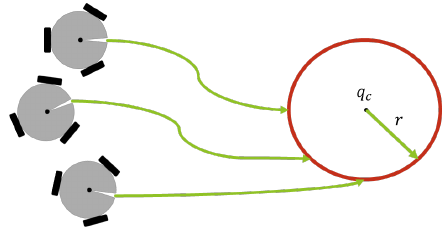
Figure 3. Geometric shape